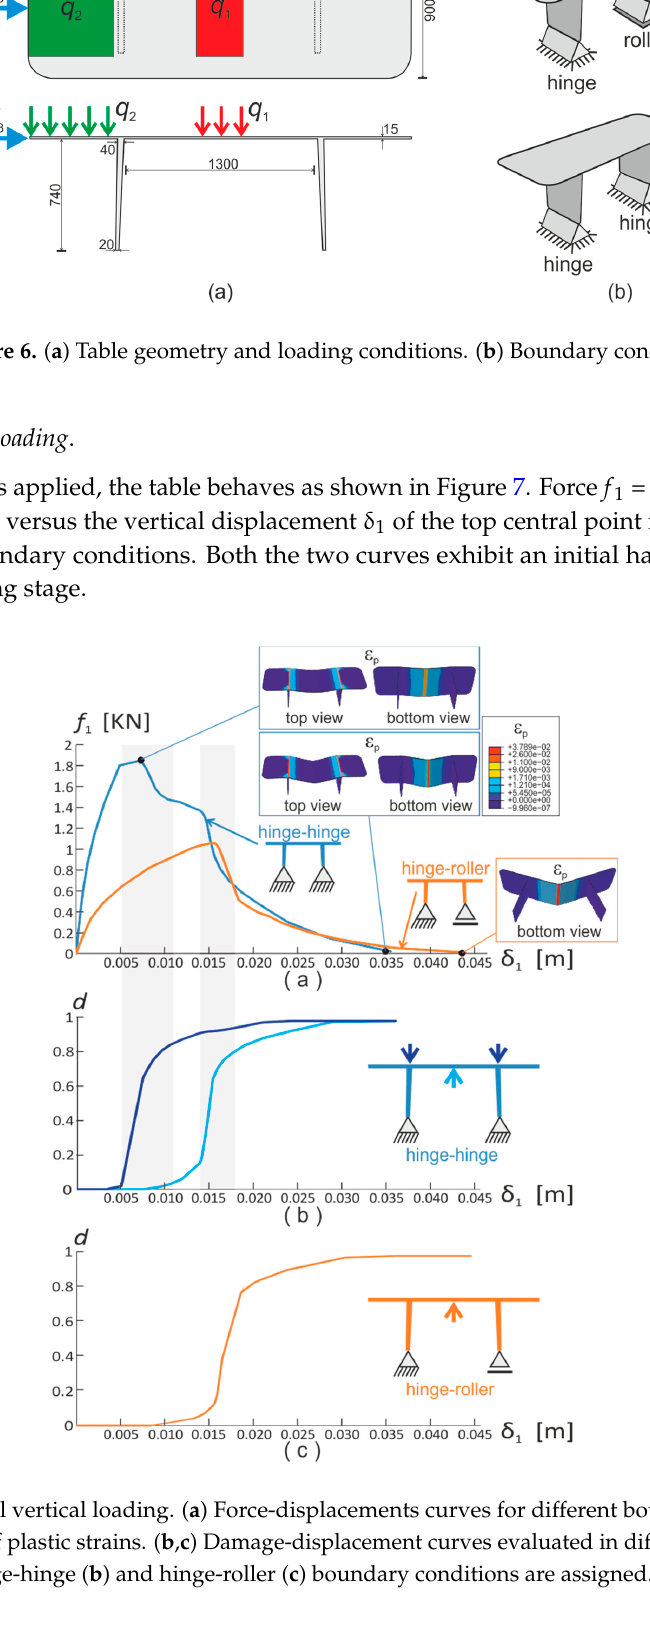
Figure 7. Central vertical loading. ( a ) Force-displacements curves for different boundary conditions, and snapshots of plastic strains. ( b , c ) Damage-displacement curves evaluated in different points of